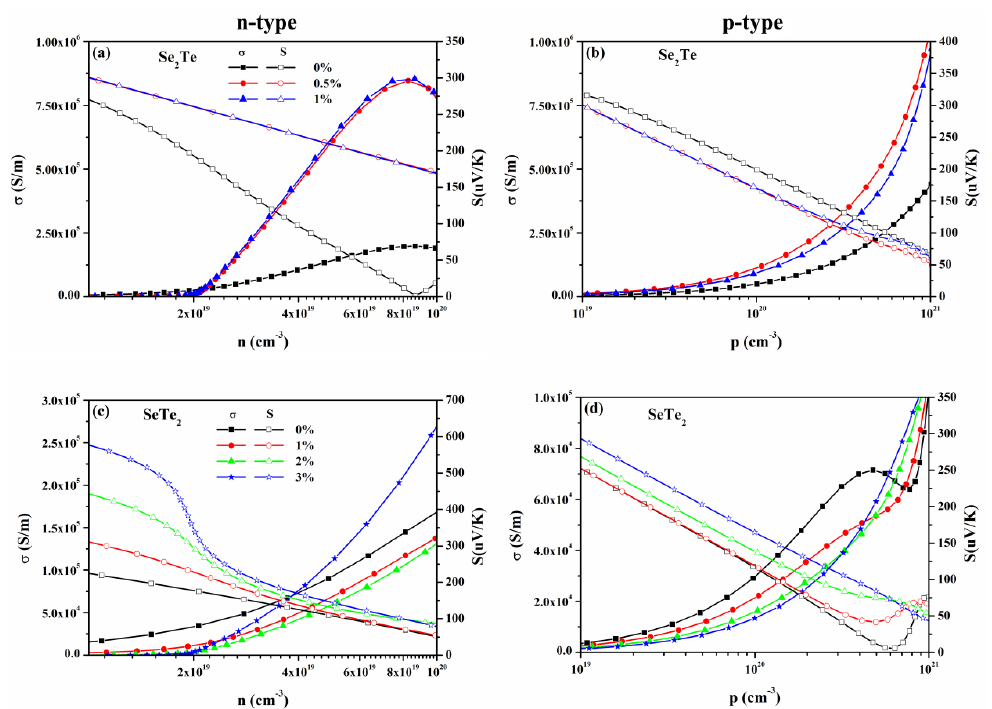
Figure 5. (Color online) The electronic conductivity σ and Seebeck coefficient S of ( a , b ) Se 2 Te and ( c , d ) SeTe 2 monolayers with different applied strain as a function of concentration for both n- and p-type doping at 300 K.